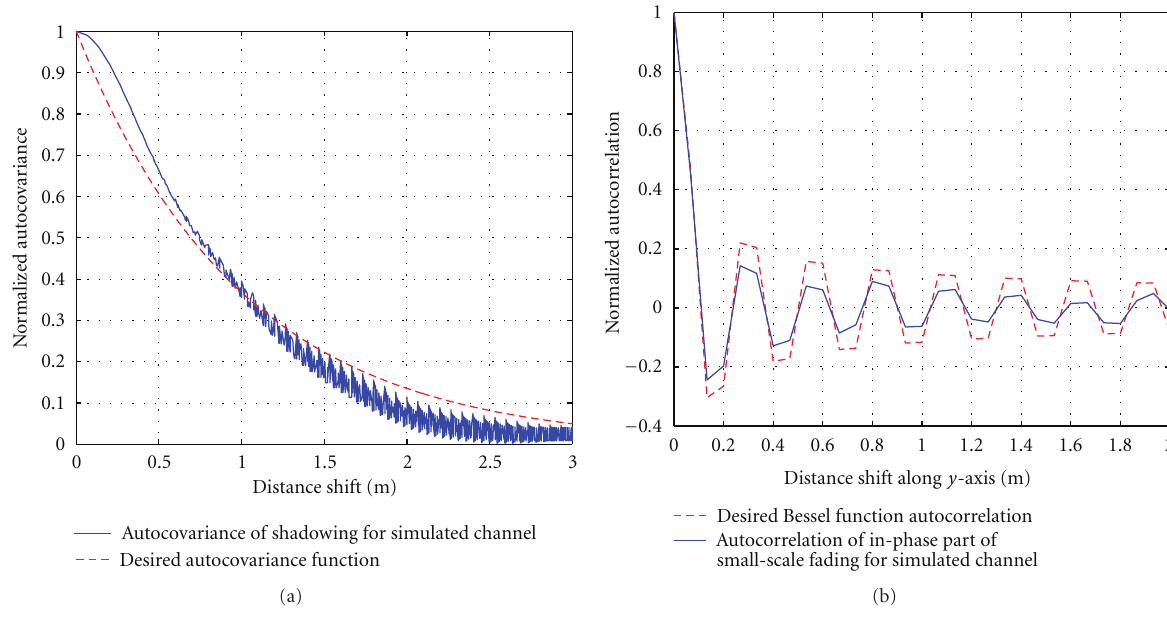
Figure 17: (a) A slice of the normalized autocovariance function of shadowing for the simulated two-dimensional channel of Figure 16 and its exponential match. (b) A slice of the autocorrelation function of the in-phase part of small-scale fading and its Bessel function match. It can be seen that our simulated channel has the desired correlation